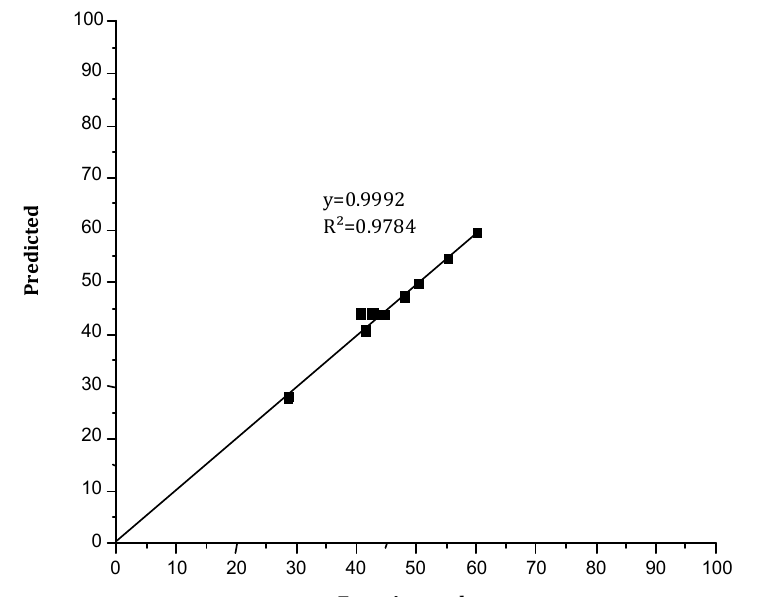
Figure 13. The back-extraction yield of Cr(VI) predicted versus the experimental yield.